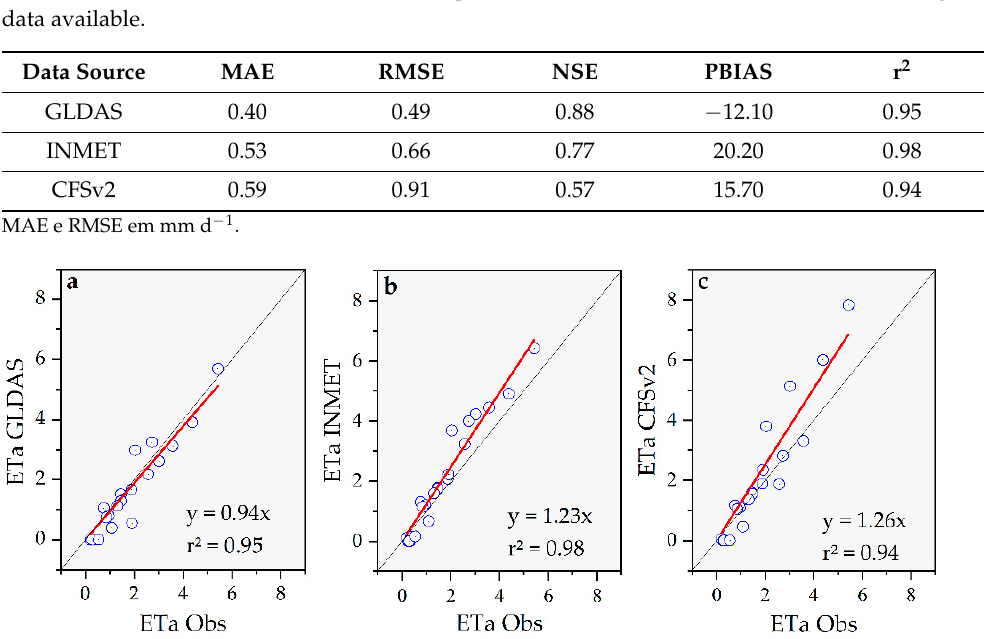
Figure 5. Comparing ETa estimated by the SSEBop-Br model for the three sources of meteorological data, ( a ) GLDAS, ( b ) INMET, ( c ) CSFv2, and ETa observed in a flux-tower site.